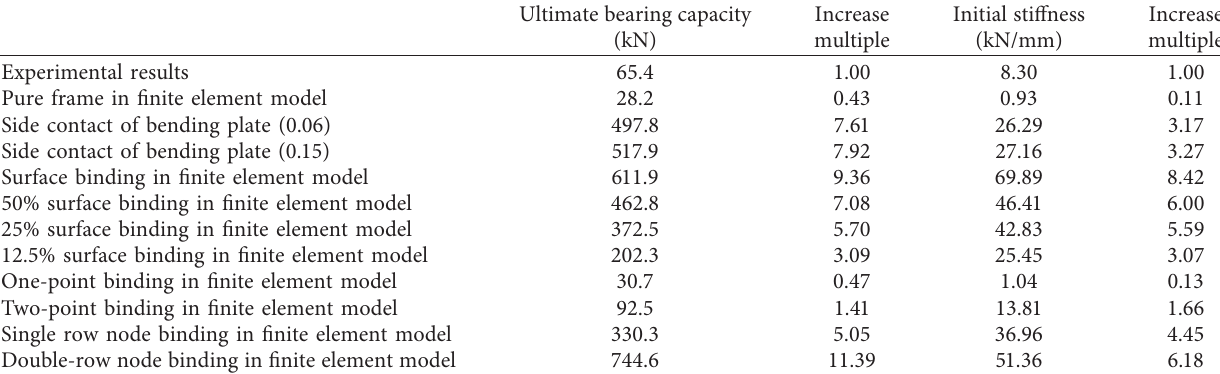
Table 6: Comparison of the ultimate bearing capacity and initial stiffness for QY-2. Ultimate bearing